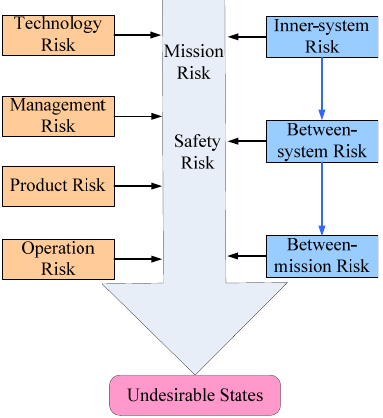
Figure 2. Configuration risks definition of the space station.